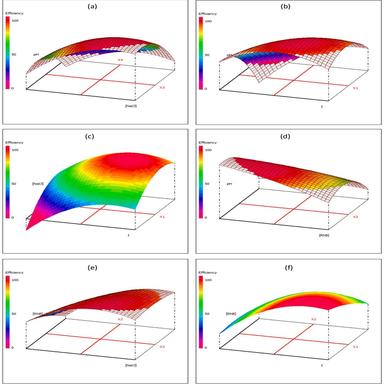
Response surface and interaction curves of the different parameters (a) pH - , (b) current density – pH, (c) current density - , (d) pH - , (e) - and (f) - current density.